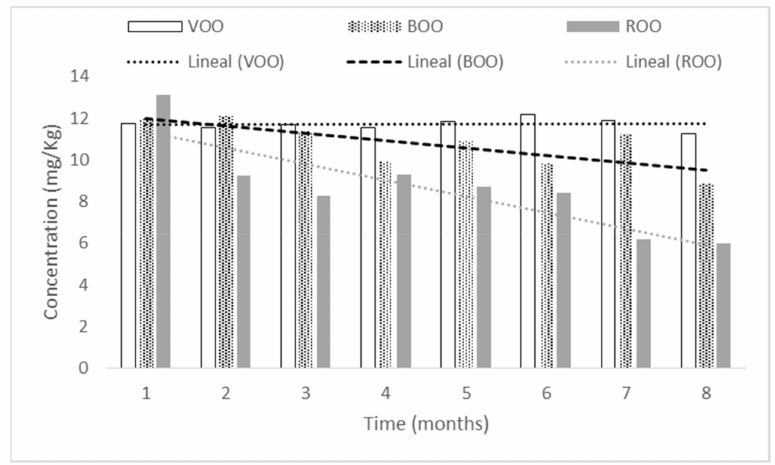
Figure 5. Luteolin concentration (mg/kg) in the storage process for the three